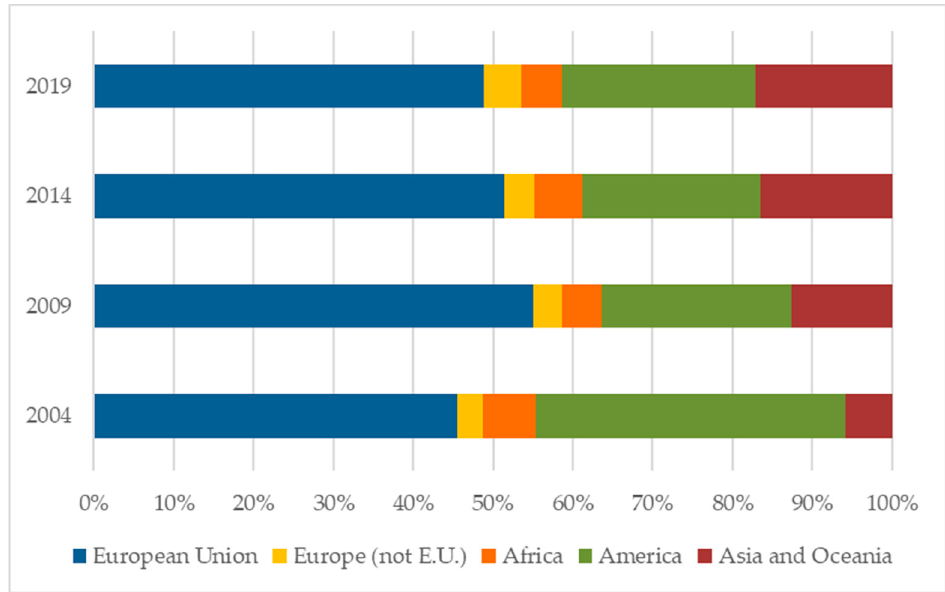
Figure 5. Evolution of the foreign population in El Terreno. Source: Own elaboration based on the Continuous Population Register, INE (National Statistics Institute).